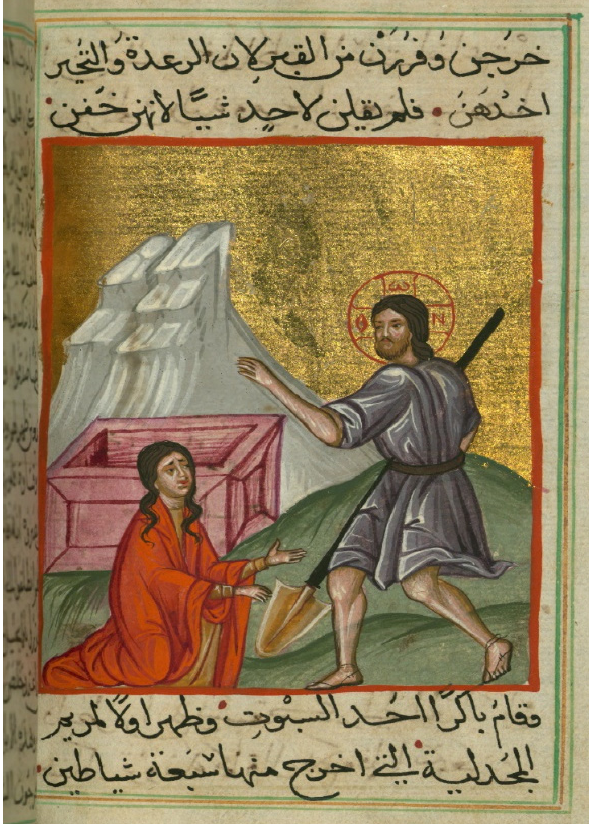
Figure 3. Walters Ms. W.592. f.131 r . Jesus appearing to Mary as a gardener. Copyrights: The Walters Museum CC0 1.0 Universal.